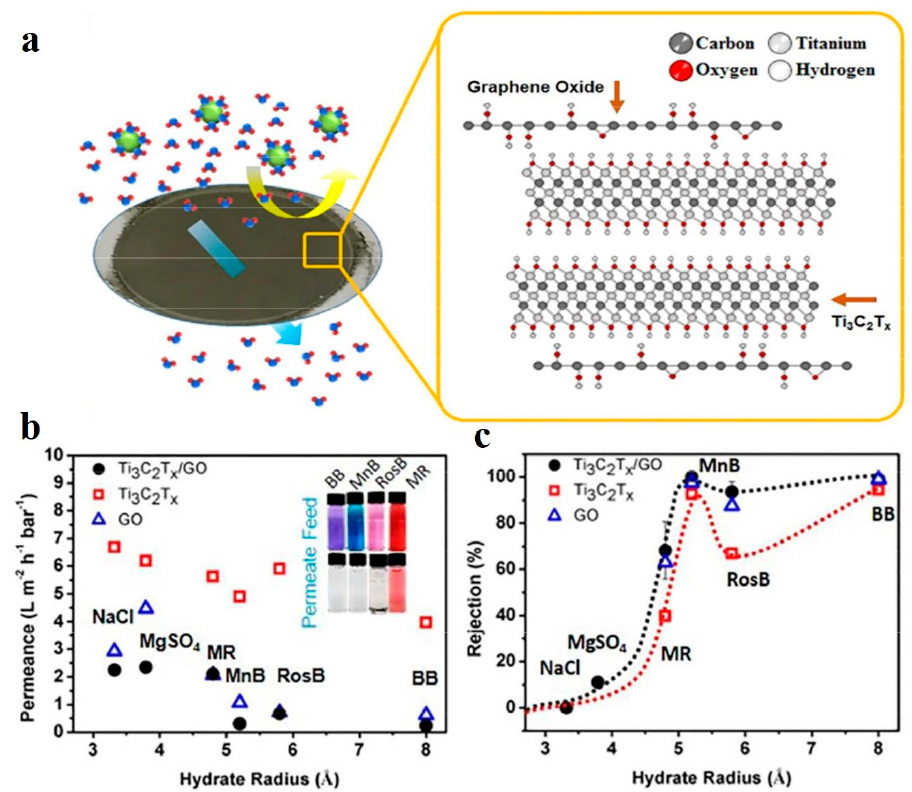
Figure 4. ( a ) Digital photograph of an MXene (Ti 3 C 2 T X )/GO-based composite membrane for water purification and a schematic representation of an ionic and molecular sieving mechanism. ( b ) Separation efficiency of various probe molecules with different sizes through a 90 nm-thick Ti 3 C 2 T x /GO composite membrane before and after filtration. ( c ) The separation performance of a pristine GO, MXene, and MXene/GO composite membrane against different probe molecules. Reprinted with permission from [65]. Copyright 2017 American Chemical Society.